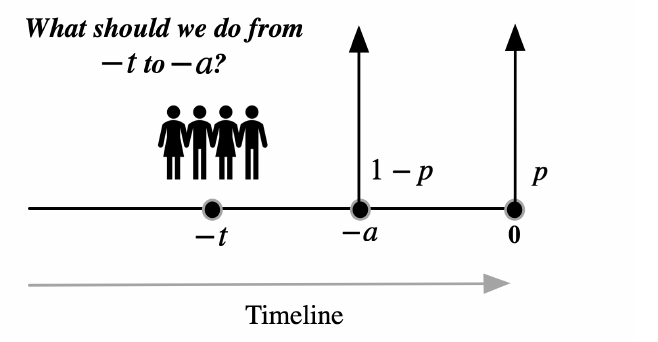
Figure 1. Two possible deadlines, one is at 0 with probability p , and the other one is at − a with probability 1 − p . Player makes a plan taking into consideration of both possible